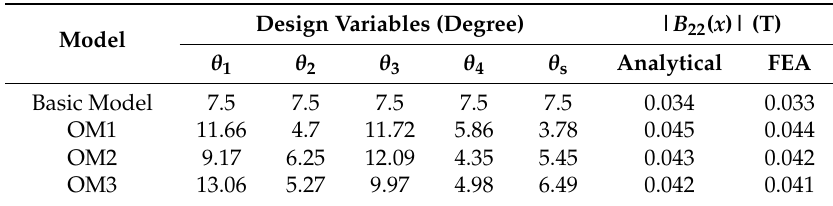
Figure 11. Air-gap permeance in the basic and optimal models. ( a ) Distributions; ( b ) Harmonic components. Table 3. Optimization